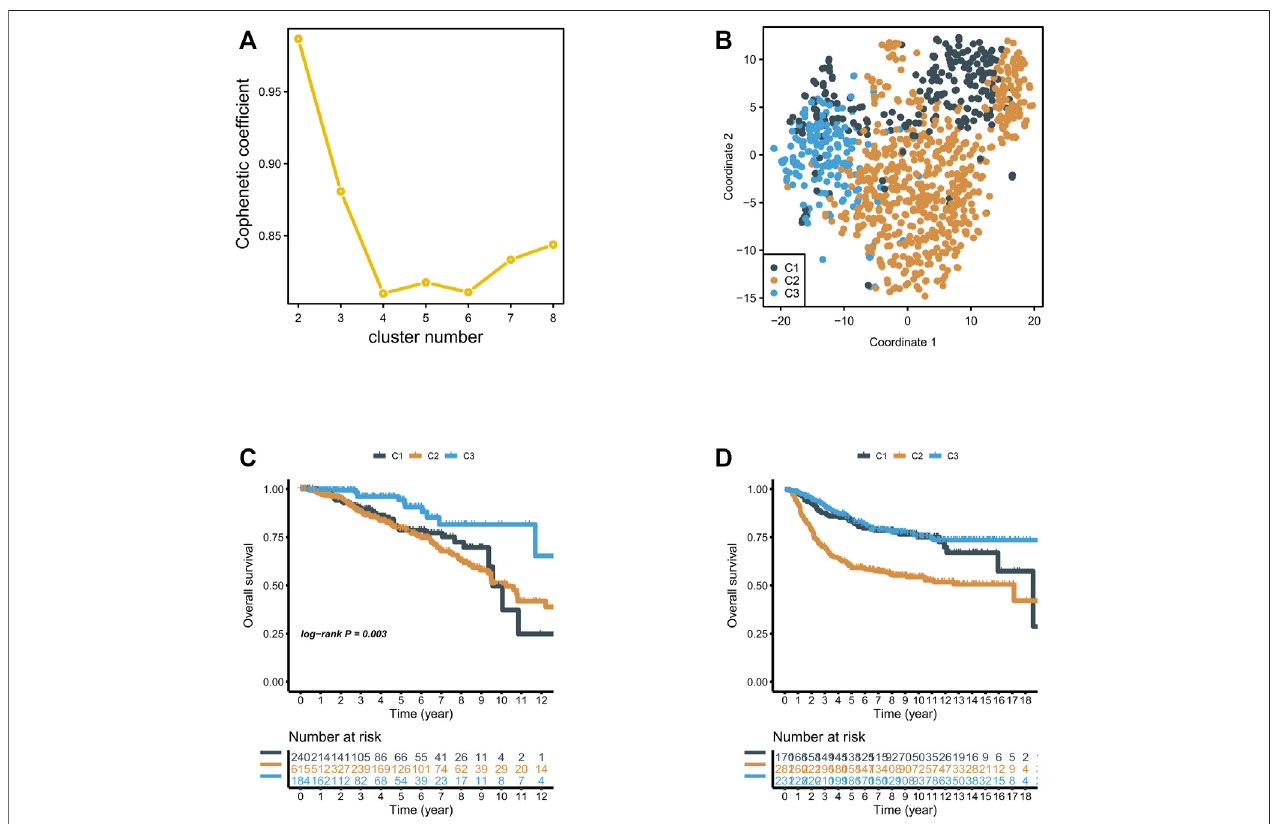
FIGURE 1 | (A) NMF clustering was performed for 816 metabolism-related genes, and the af fi nity correlation coef fi cient was k = 2 – 8; (B) Classi fi cation of breast cancer into three subgroups using T-SNE analysis; (C,D) Overall survival of three subgroups in the TCGA and Xena Breast Cancer (Yau 2010) cohorts.